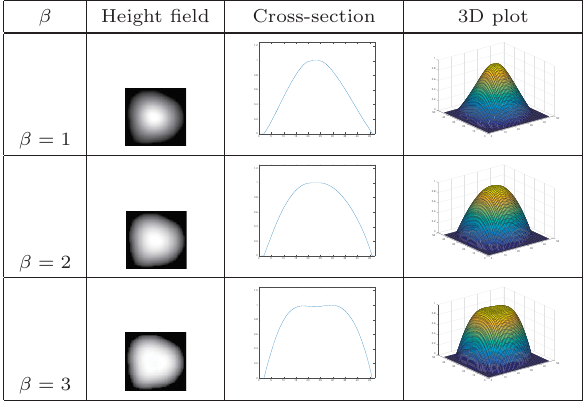
Fig. 8 Constructing a height field at varying scales of gradient magnitude on c o .